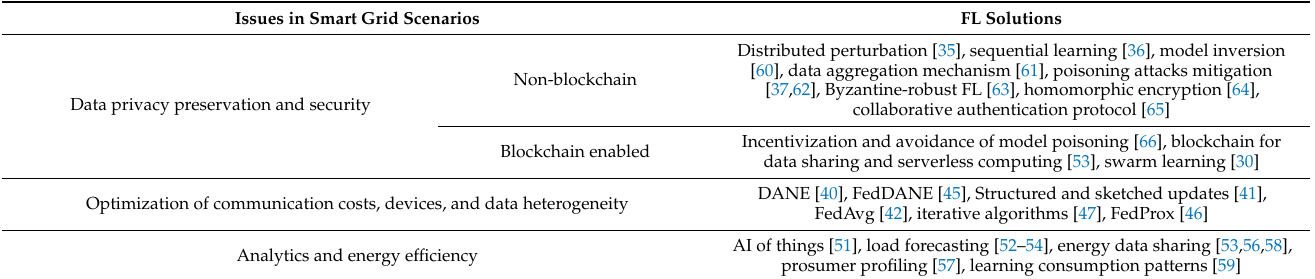
Table 1. FL relevance for smart